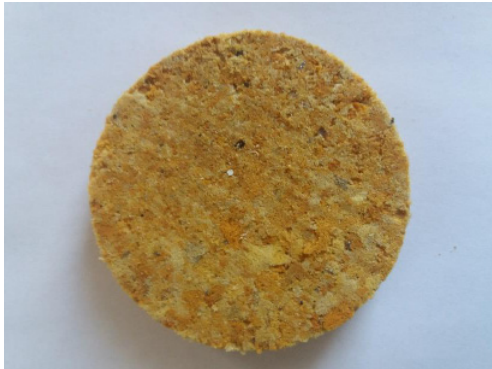
Figure 5. Ekomolitan after pressing.